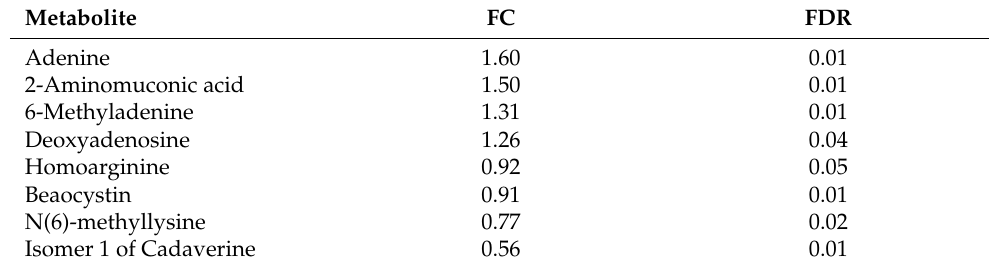
Table 2. Differentially abundant amine/phenol-metabolites in rumen fluid of beef steers with divergent residual feed intake